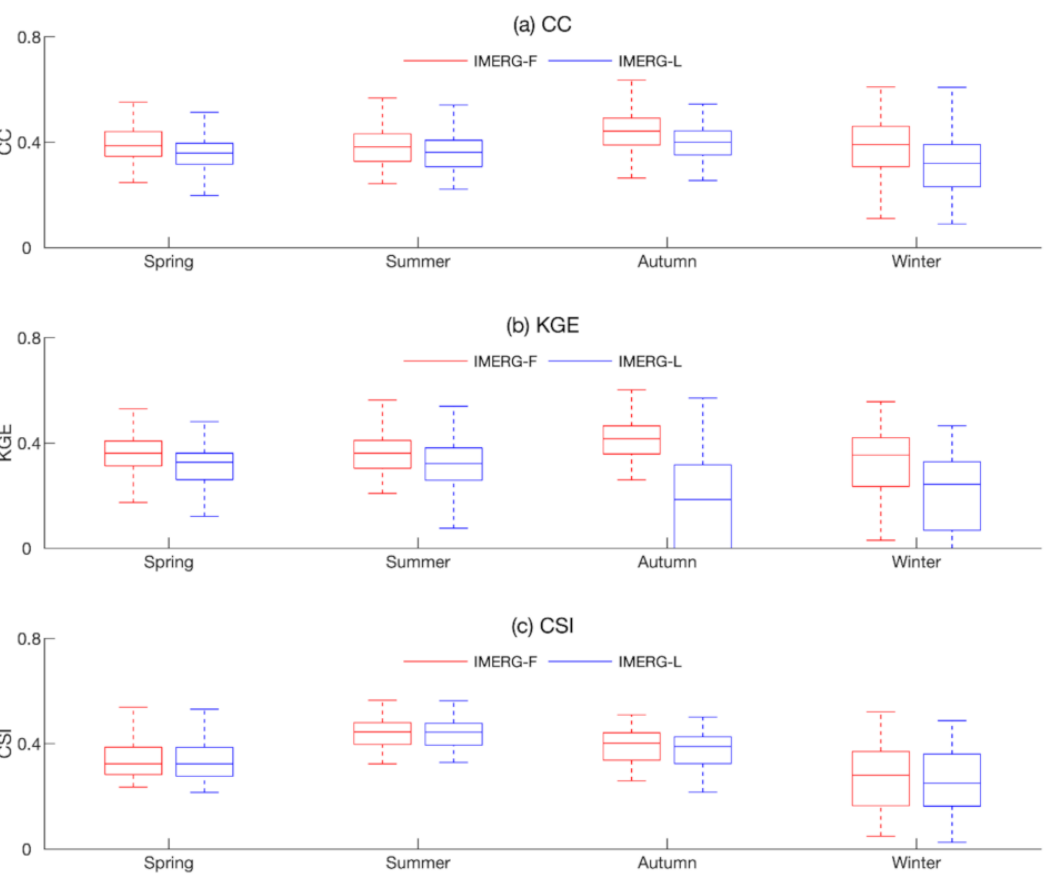
Figure 7. The distributions of three metrics CC, KGE, and CSI for the IMERG-F and IMERG-L precipitation products at the seasonal